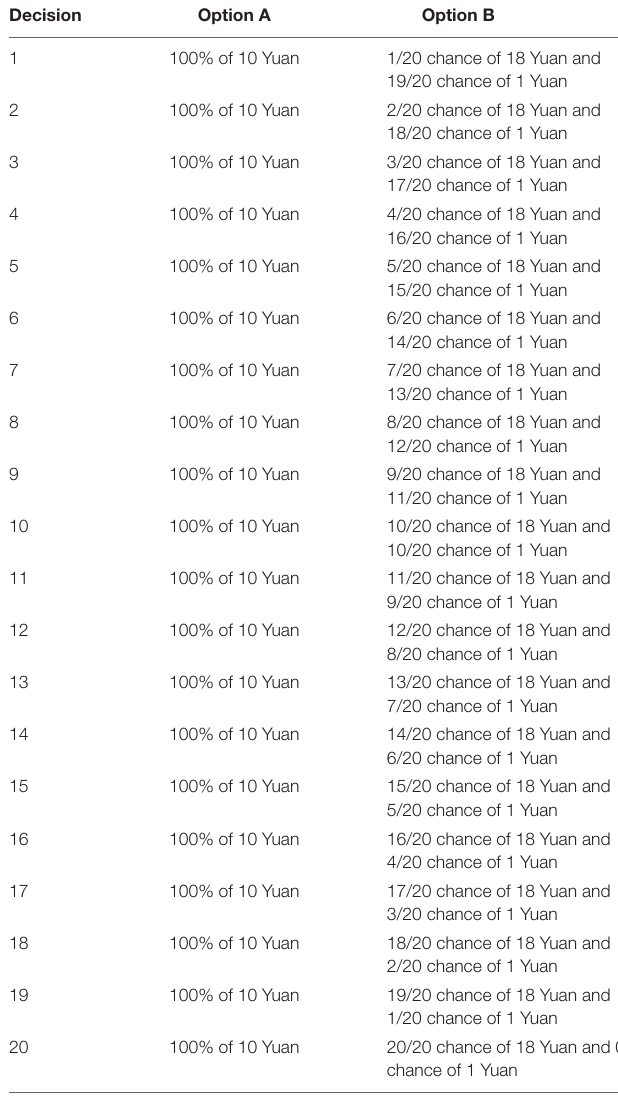
TABLE 1 | The 20 paired incentivized lottery-choice